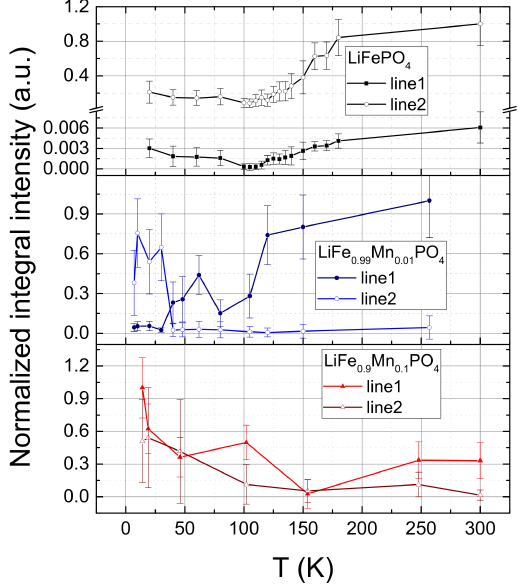
Figure 8. Temperature dependence of the normalized integral intensity of resonance signals in LiFe 1 − x Mn x PO 4 (x = 0, 0.01,